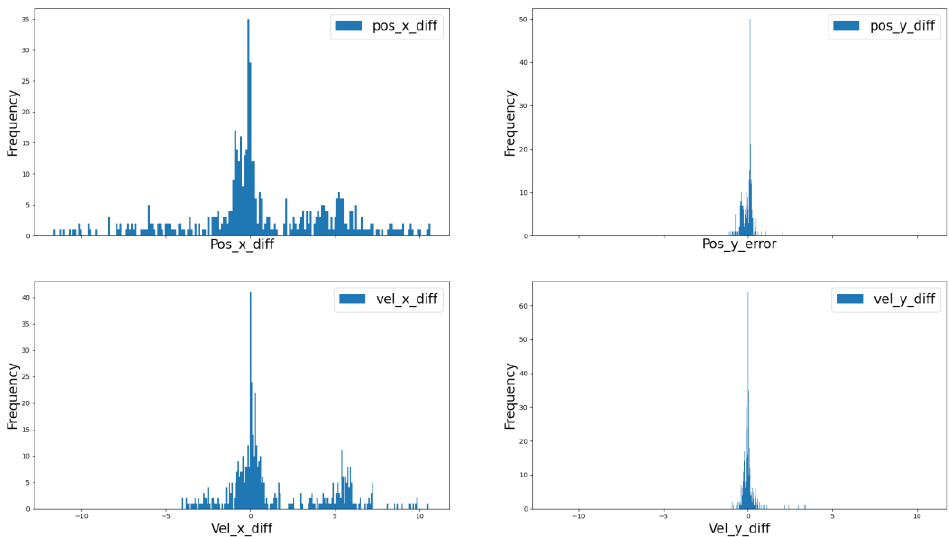
Figure 18. Error frequency distribution.